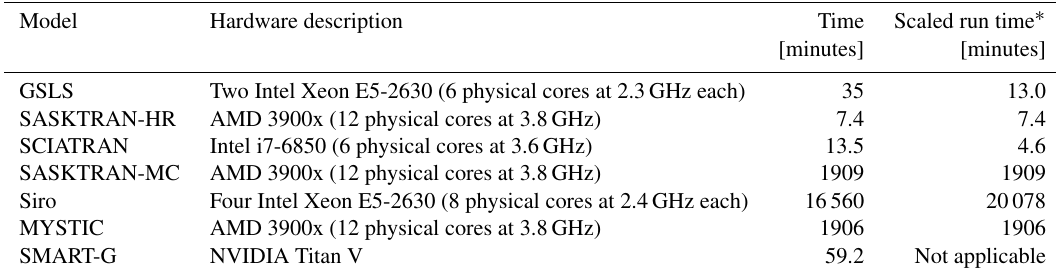
Table 4. Estimated time to execute all multiple-scattering-enabled, no-refraction tests. This includes 3 effective surface albedos, 3 different atmospheric compositions, 11 wavelengths, 9 solar geometries, and 80 lines of sight. The MC models were executed to the precision shown in Fig. 10 (see text for more detail).